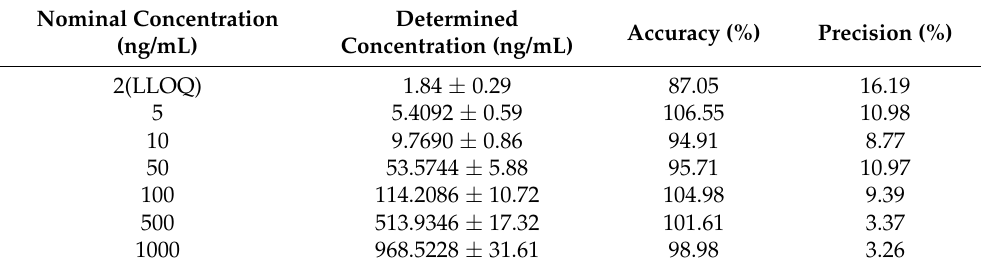
Table 1. Accuracy and precision in the calibration curve of oxypeucedanin.